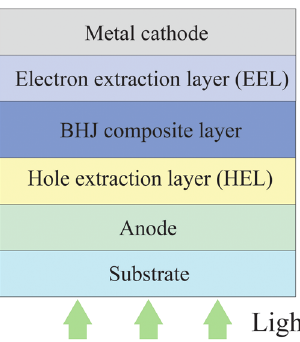
Figure 5: Device structure of a typical OPV with NPs doped into